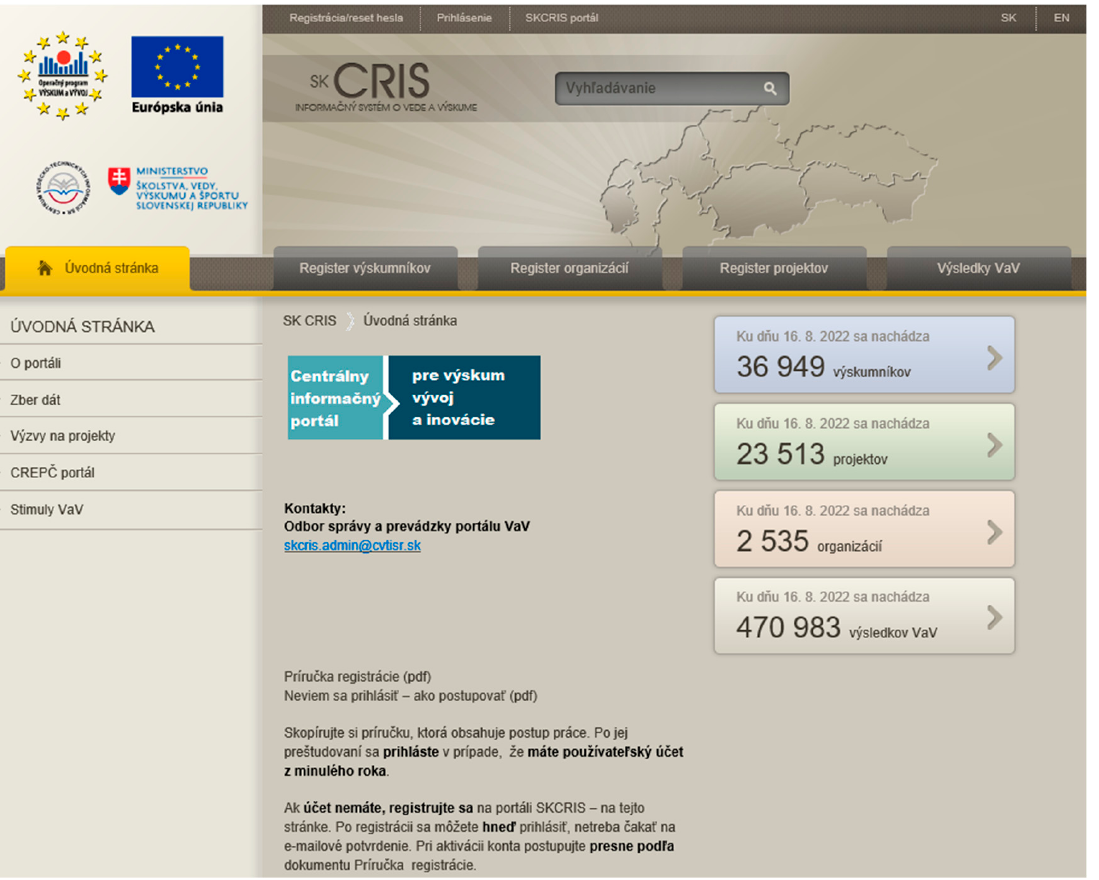
Figure 2. Main page of SK CRIS—number of records.